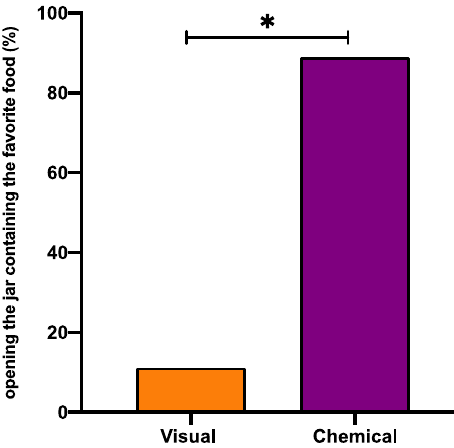
Figure 4. Visual vs. chemical perception in Octopus vulgaris . Percentage of the successful decisions to open as first the jar that contained the preferred food, based on chemical (purple) or visual (orange) cues. Wilcoxon matched-pairs test vs. T1 significance is denoted with asterisks * for p < 0.05.